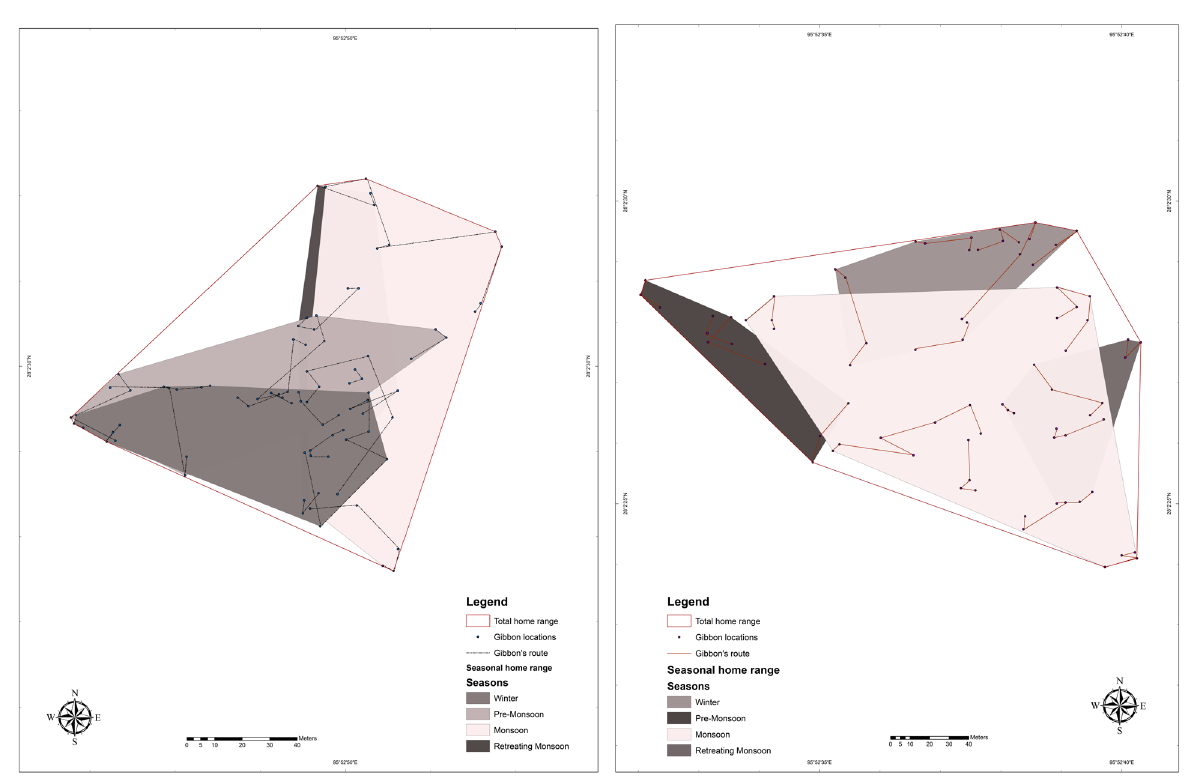
shades.Figure 3a. Home range of Group A (left) and Group B (right) showing seasonal pattern in different